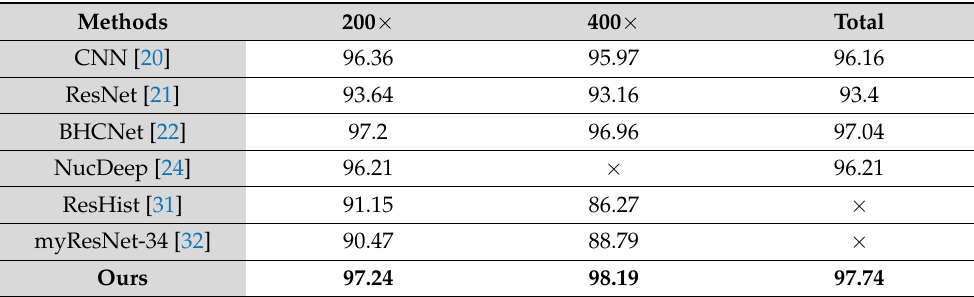
Table 4. Binary classification accuracy comparison.